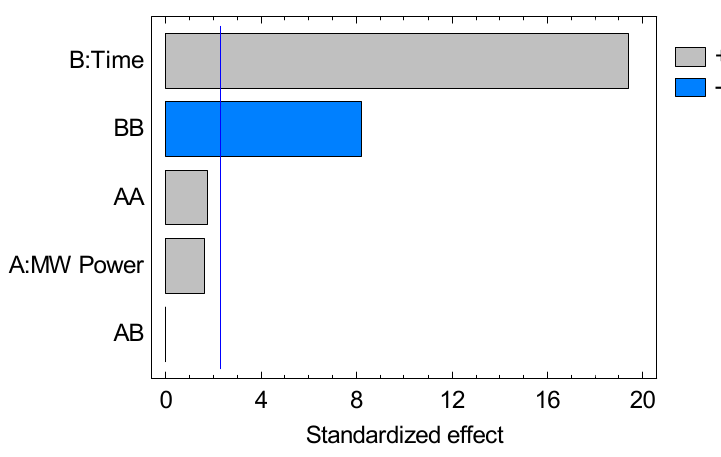
Figure 3. Standardized Pareto chart of multivariate response for VOC